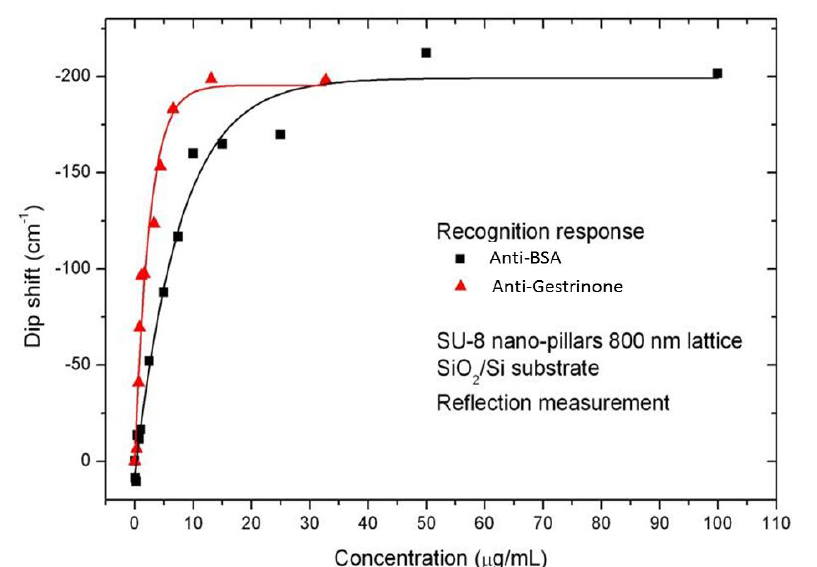
Figure 6. Dip shift against antibody concentration for bovine serum albumin (BSA)-anti-BSA and gestrinone-anti-gestrinone